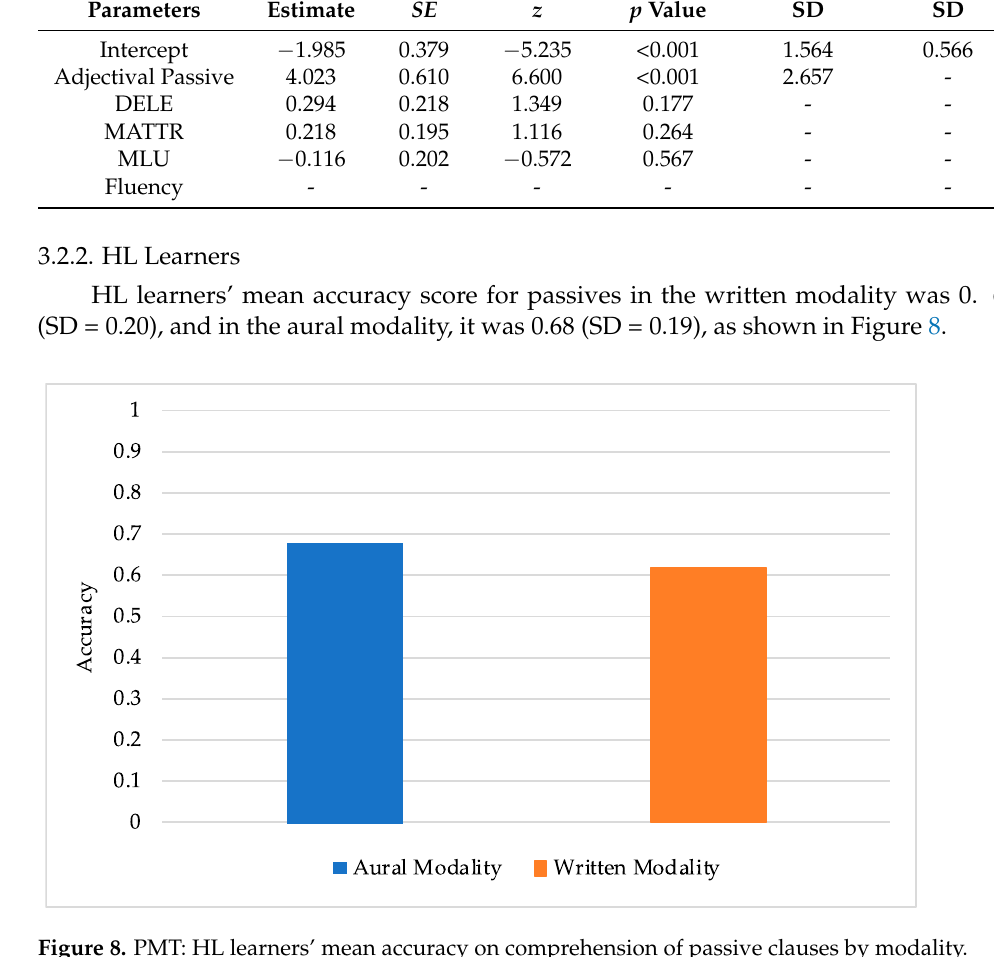
Mean = 8.17 courses SD = 7.95